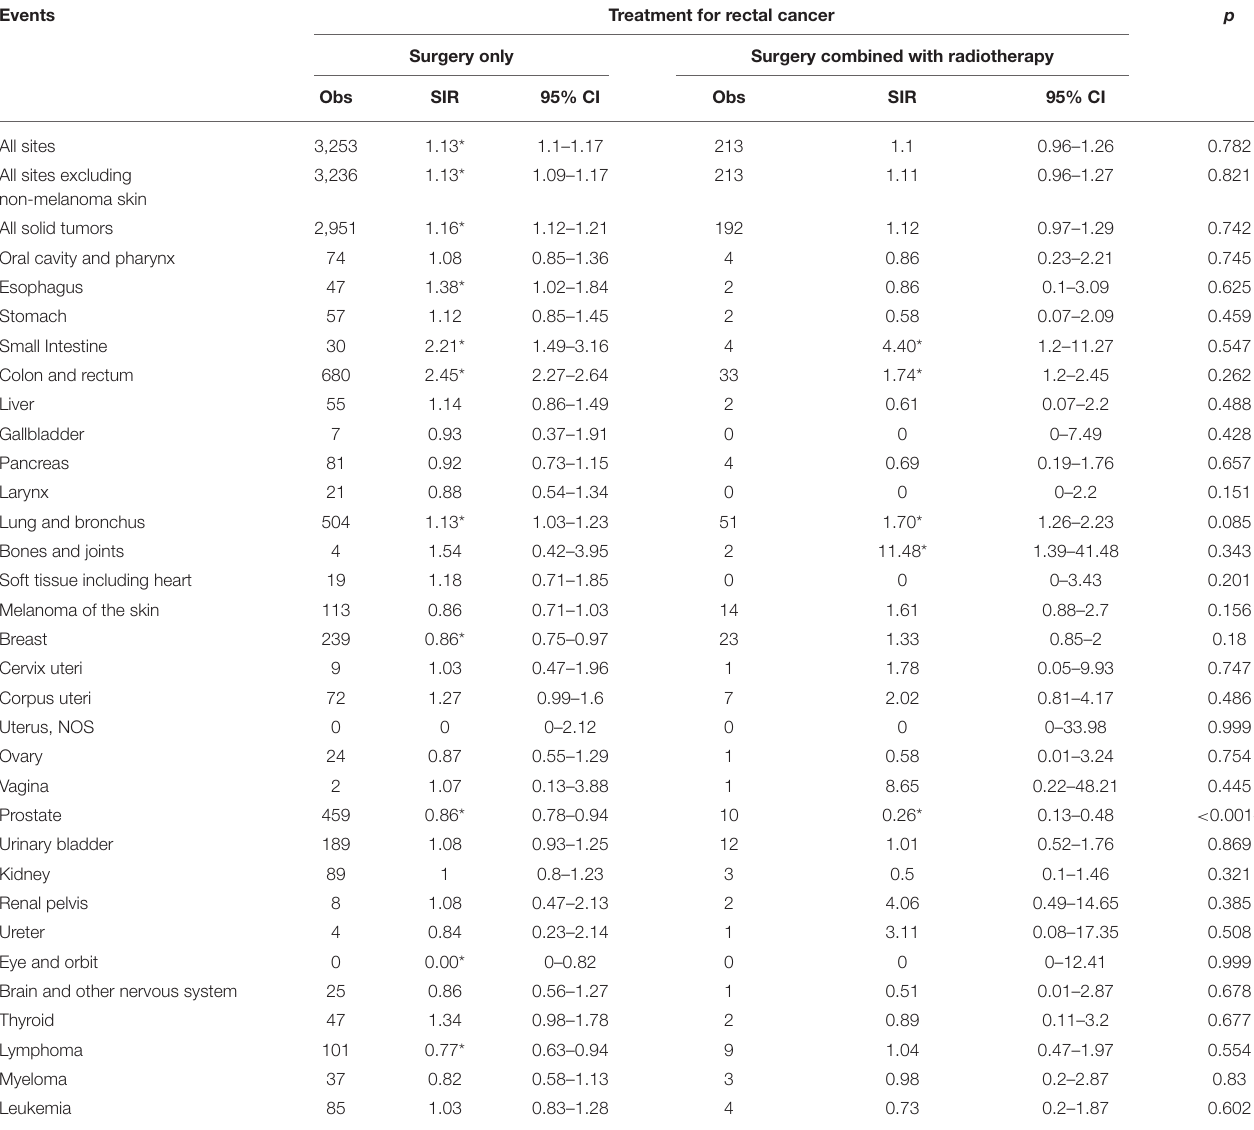
TABLE 4 | SPM risks at various anatomical sites based on previous surgery and radiotherapy treatments in rectal CA